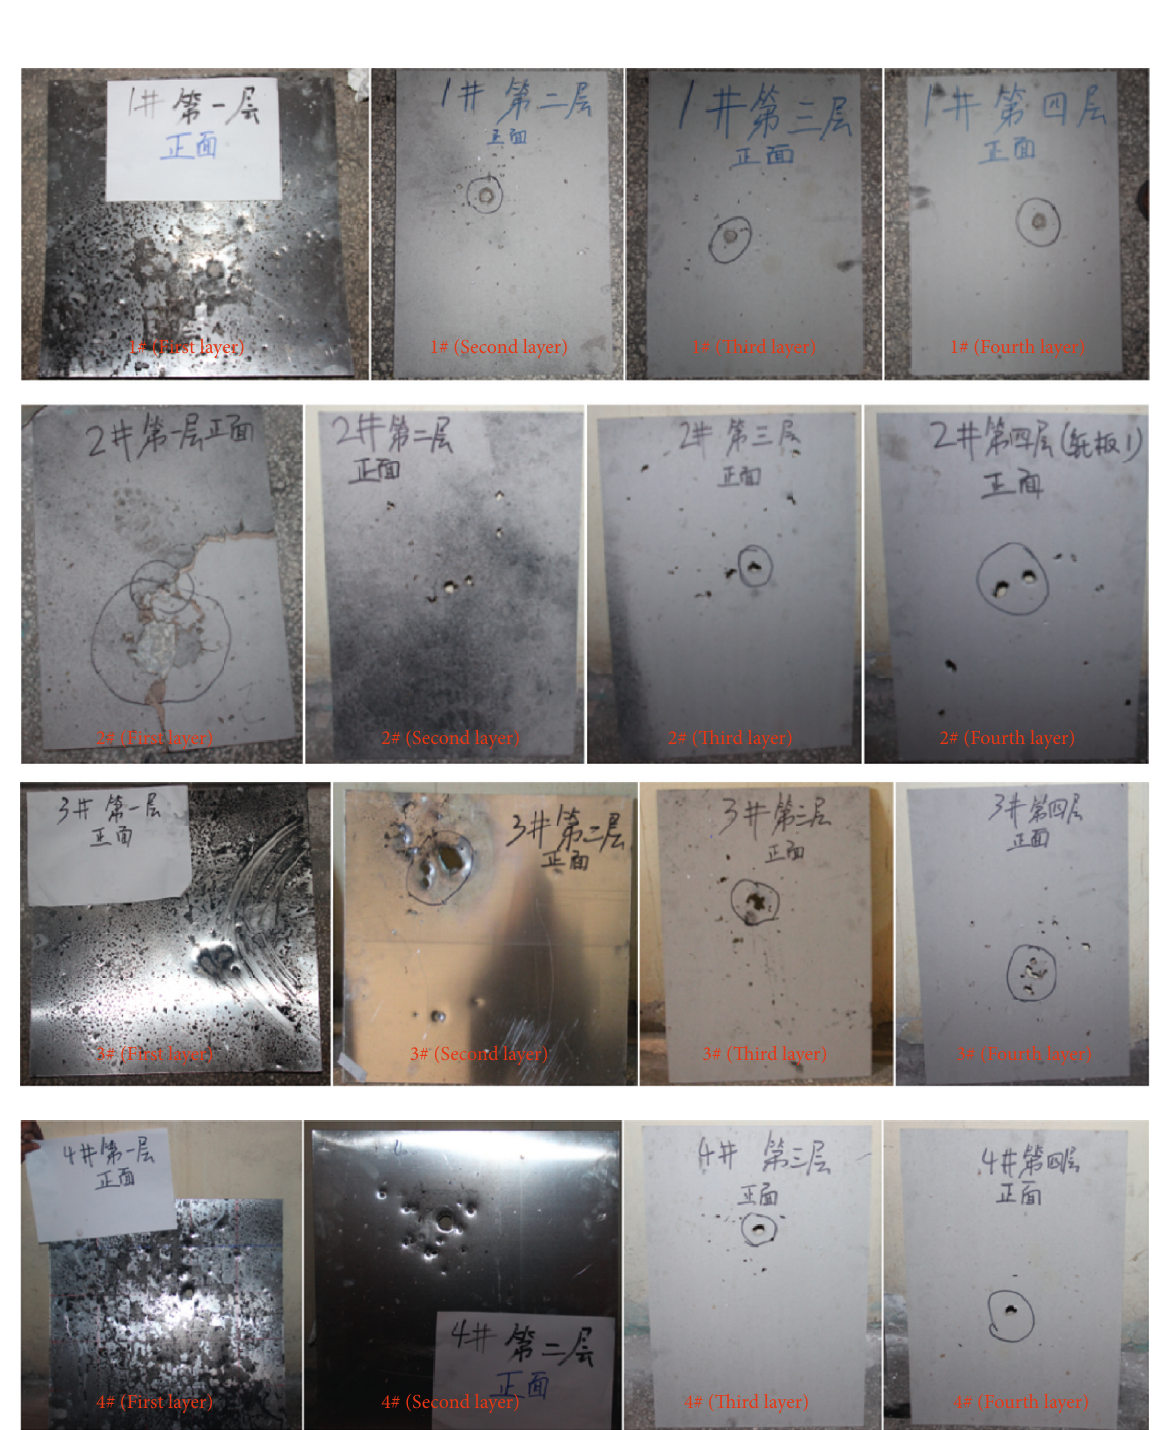
Figure 5: Overview of the retrieved target